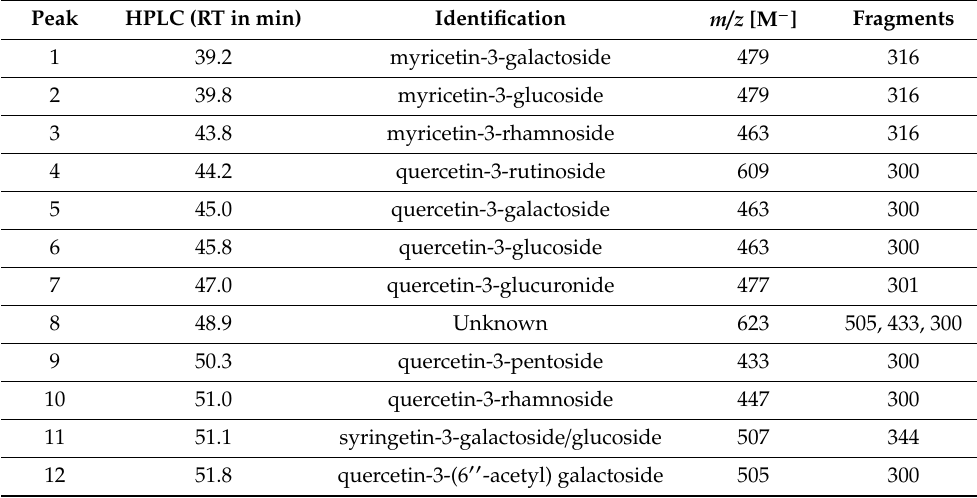
Table 2. Peak assignments, retention times (RT in min), and mass spectral data of flavonols in extract from WBB powder.